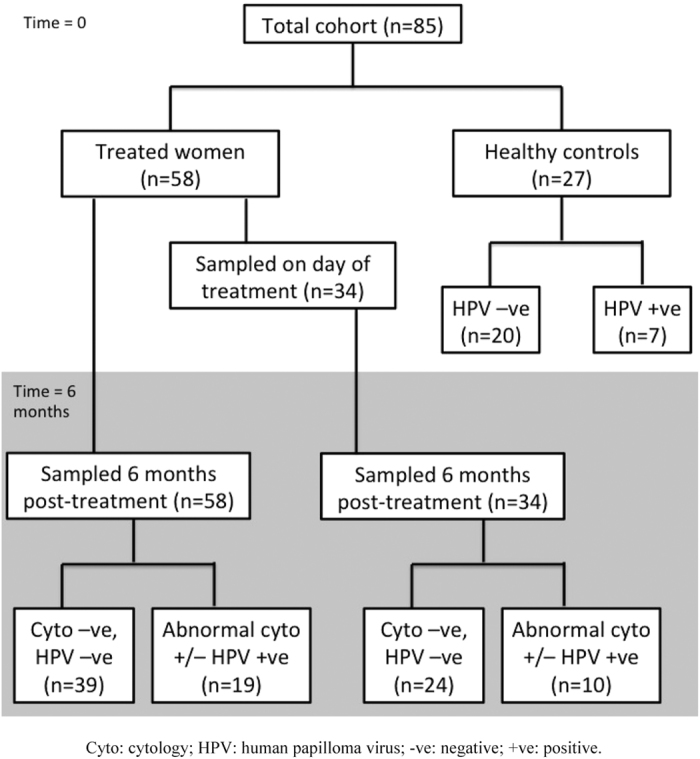
Flowchart of the included population and different comparison groups.